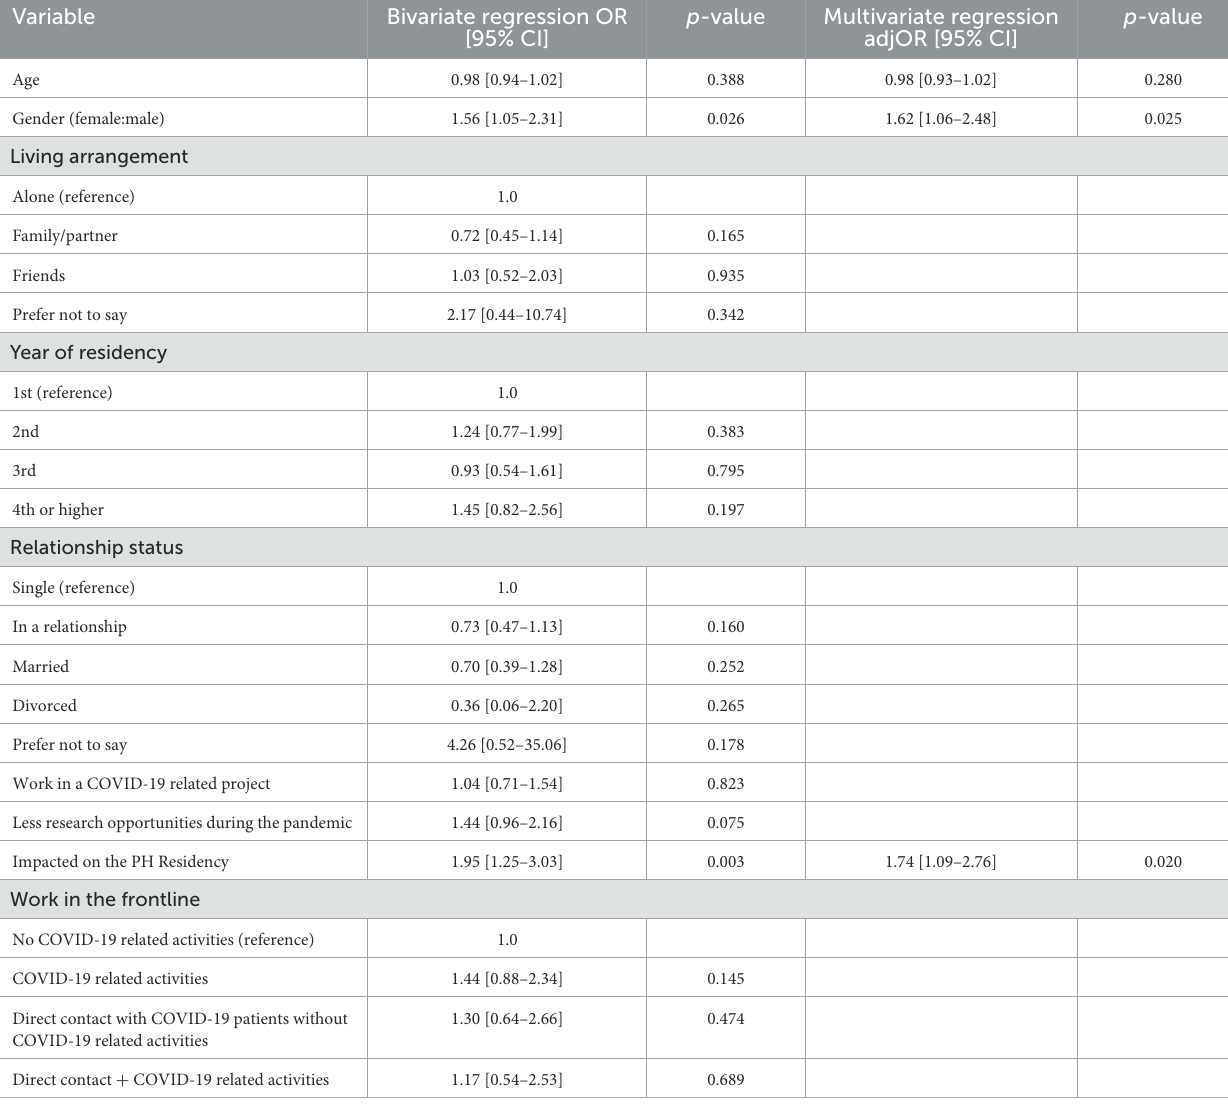
TABLE 2 Factors associated with depression, resulting from the bivariate and multivariate regression analysis of the data (Public Health Residents’ Mental Health, Europe, 2021–2022). Variable Bivariate regression OR